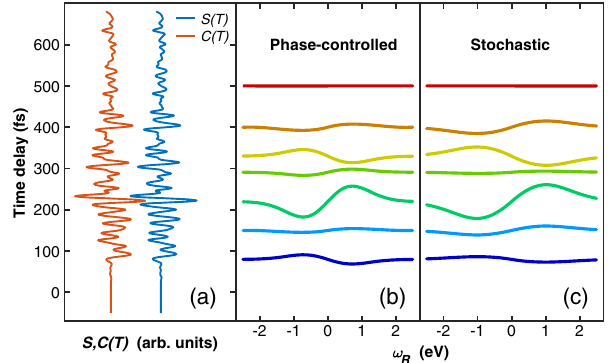
S,C(T) (arb. units)